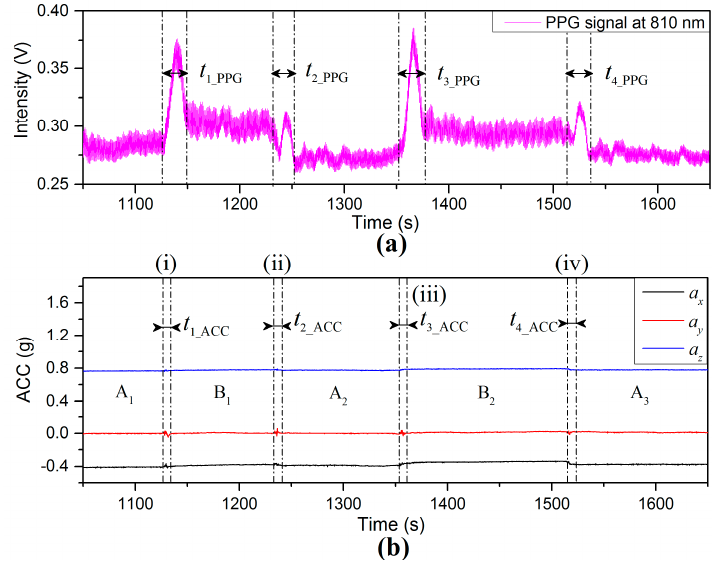
Figure 11. ( a ) PPG and ( b ) ACC signals for which the subject maintained the finger sensor probe at the same height above the floor and varied the VHD by changing body positions.